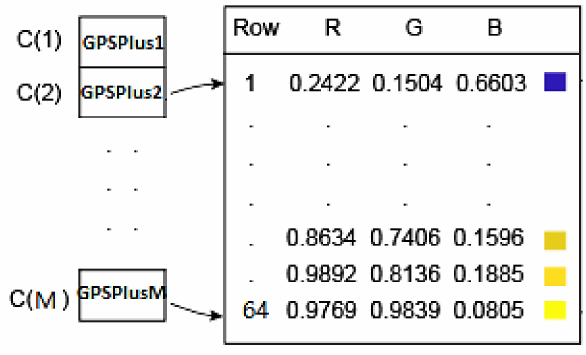
Figure 2. The colormap vs. M